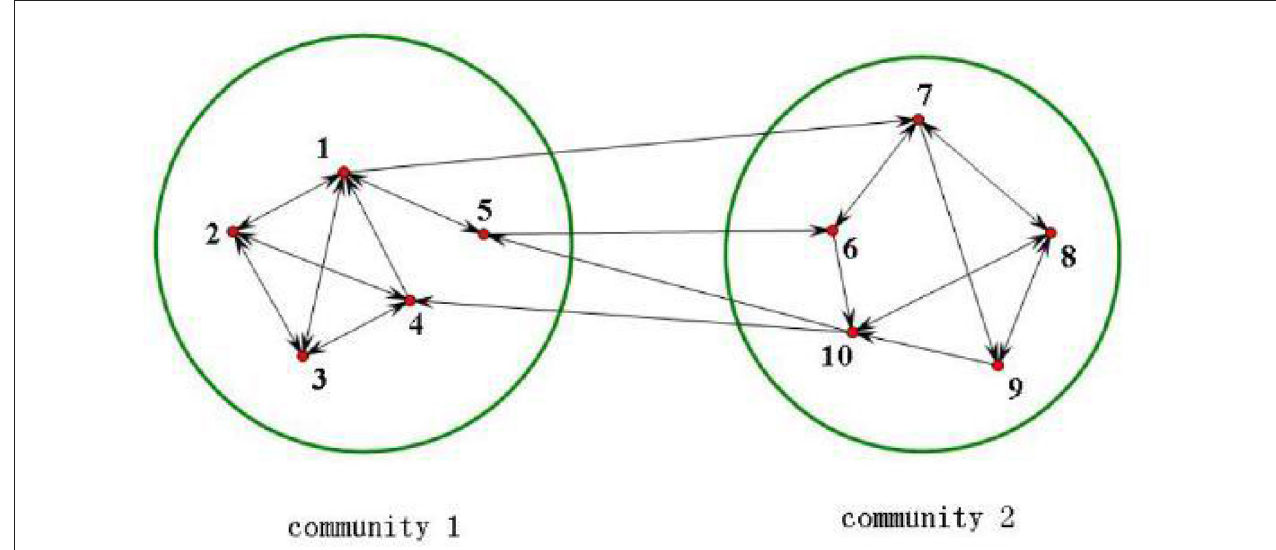
FIGURE 1 | A directed network consisting of 10 nodes with two communities.